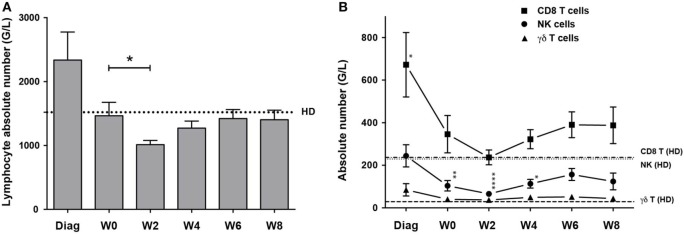
Kinetics of cytotoxic lymphocyte reconstitution. Kinetics of NK cells (round dots), CD8+ T cells (squares) and γδ T cells (triangles) reconstitution at the indicated time points. Cell counts (mean ± SEM) were measured at diagnosis of the disease, before the second consolidation (week 0, W0), at week 2, 4, 6, and 8 (W2, W4, W6, W8). (A) Absolute lymphocyte count. Dotted line corresponds to the mean of lymphocyte counts from 15 healthy donors (HD). (B) NK, γδ T, and CD8+ αβ T cell absolute counts. Horizontal lines correspond to the mean of NK, γδ T, and CD8+ αβ T cell counts from HD. When indicated a Kruskal–Wallis non-parametric test with Dunn’s posttest was performed to compute the P value for the comparisons (*P < 0.05, **P < 0.01, ****P < 0.0001).